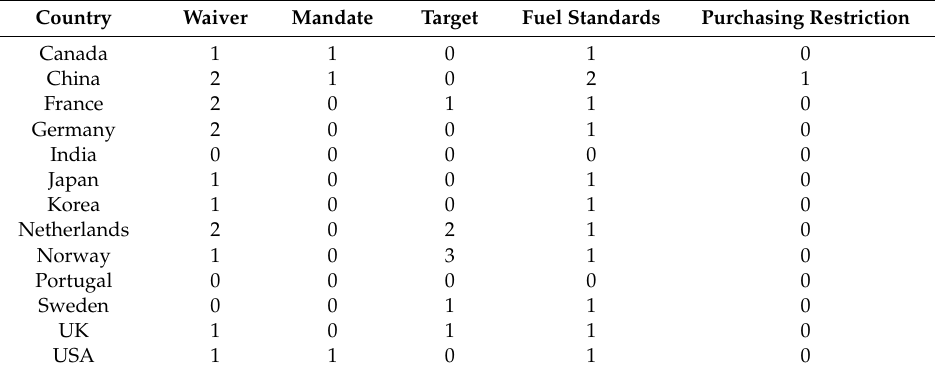
Table A3. Summary of policy value for the variable in selected countries in